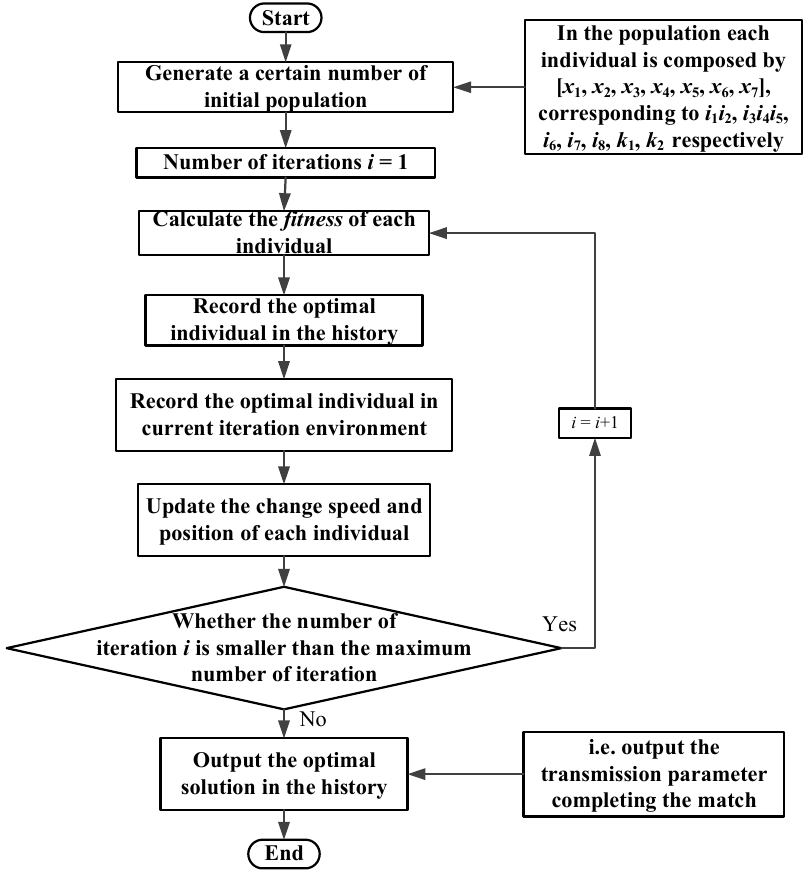
Figure 6. Flow diagram of optimization for speed regulating characteristics based on the I-PSO algorithm.